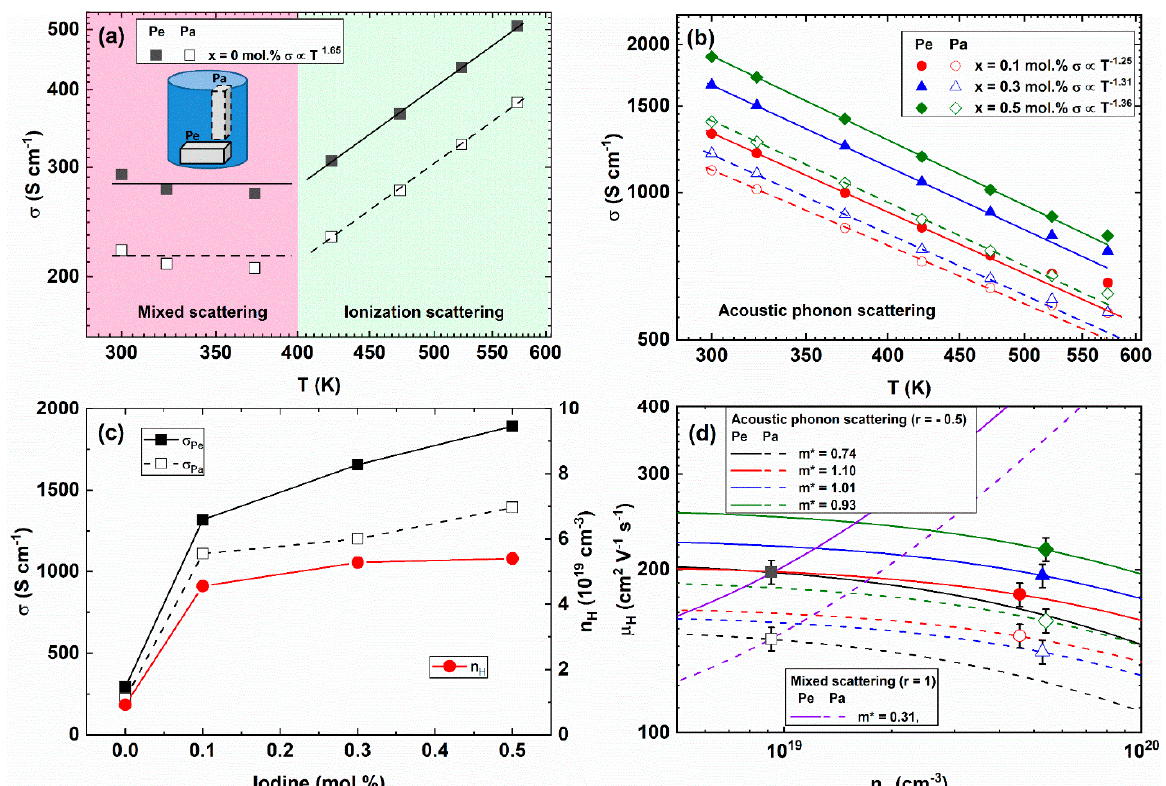
Figure 2. Temperature-dependent electrical conductivity σ (T) fitted with the mixed, ionization and acoustic scattering mechanism (lines) of the pristine (x = 0.0) compound ( a ) and iodine doped compounds (x = 0.1, 0.3, 0.5 mol.%); ( b ) Room temperature electrical conductivity (left axis, black squares) and Hall carrier concentration (right axis, red circle) as a function of the I-doping concentration ( c ) and Hall mobility with Hall carrier concentration ( d ) of the Bi 2 Te 2.85 Se 0.15 I x (x = 0.0, 0.1, 0.3, 0.5 mol.%) compounds for the Pe-direction (closed symbol, solid line) and Pa-direction (open symbol, dashed line).